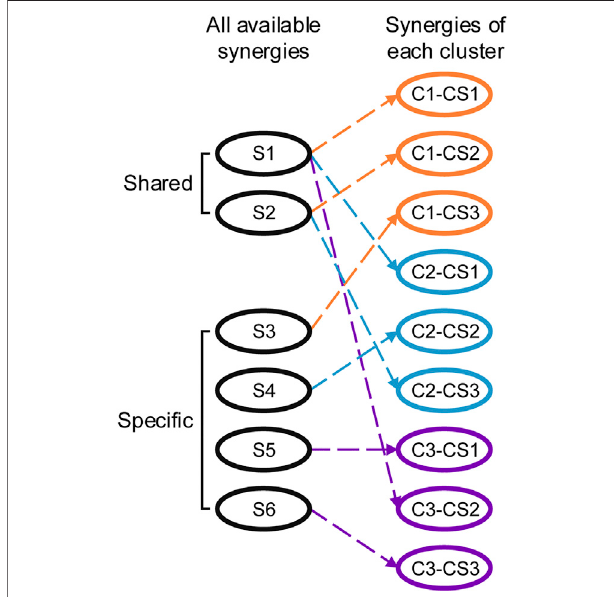
FIGURE 7 | Typical and available synergies employed by humans to achieve the various behavioral goals of the clusters. Shared and speci fi c synergies exist in the three clustersand are used tomeetcluster-independent and cluster-dependent behavioral demands,